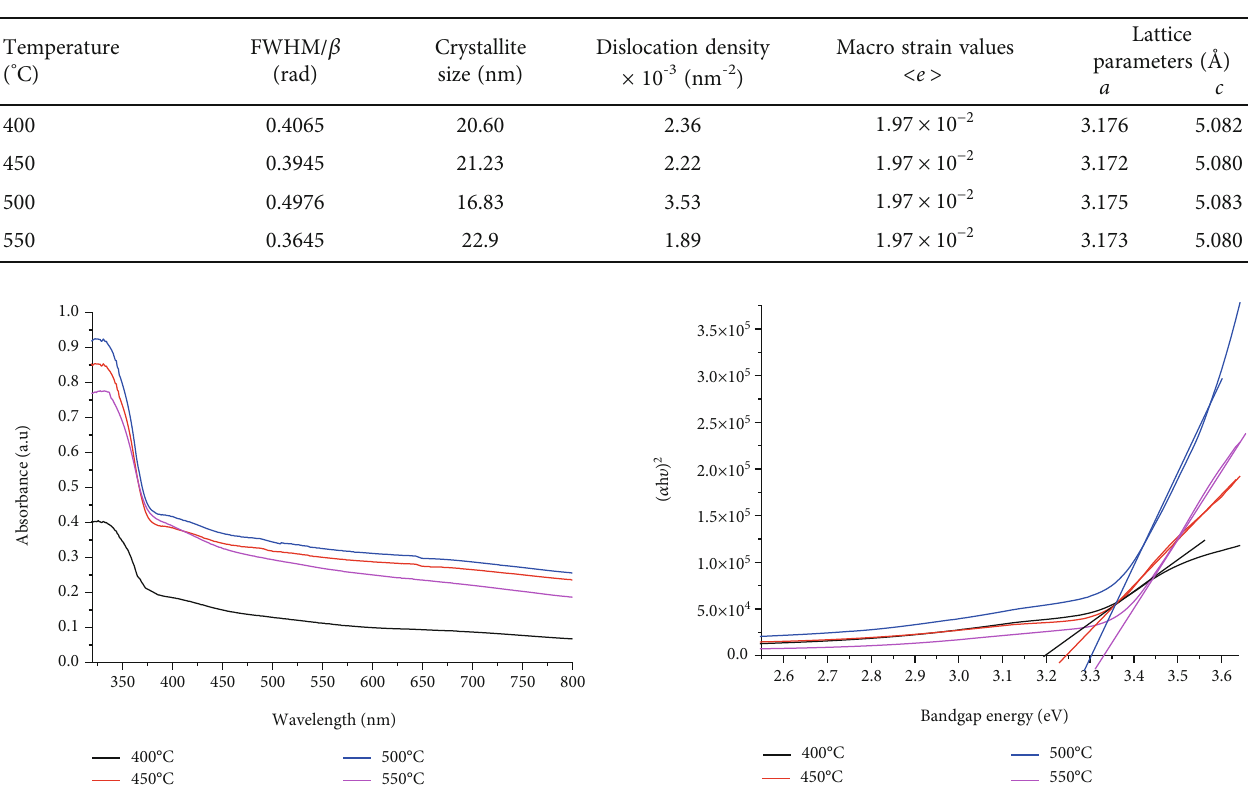
Table 1: Summary of crystal properties of FWHM, crystallite size, dislocation density, macrostrain values, and lattice parameters ( a and c ) of Mg-doped ZnO thin fi lms at di ff erent annealing temperatures.